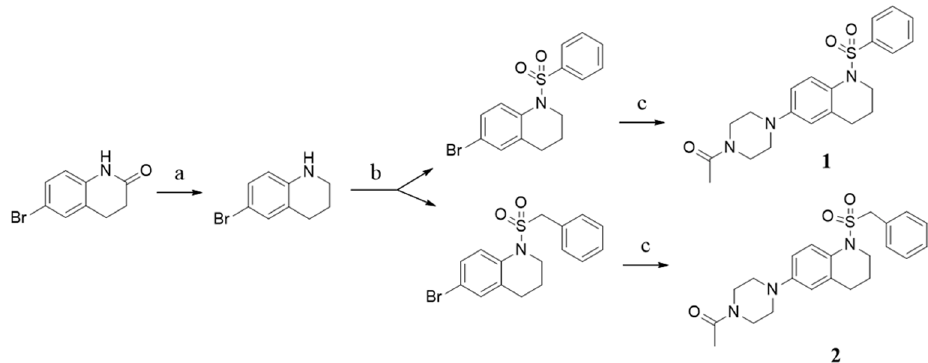
Scheme 1. Synthesis routes for compounds 1 and 2. Reagents and conditions: (a) BH3, tetrahydrofuran, rt, 3 h, reflex, 4 h, yield 74%; (b) benzene sulfonyl chloride/benzylsulfonyl